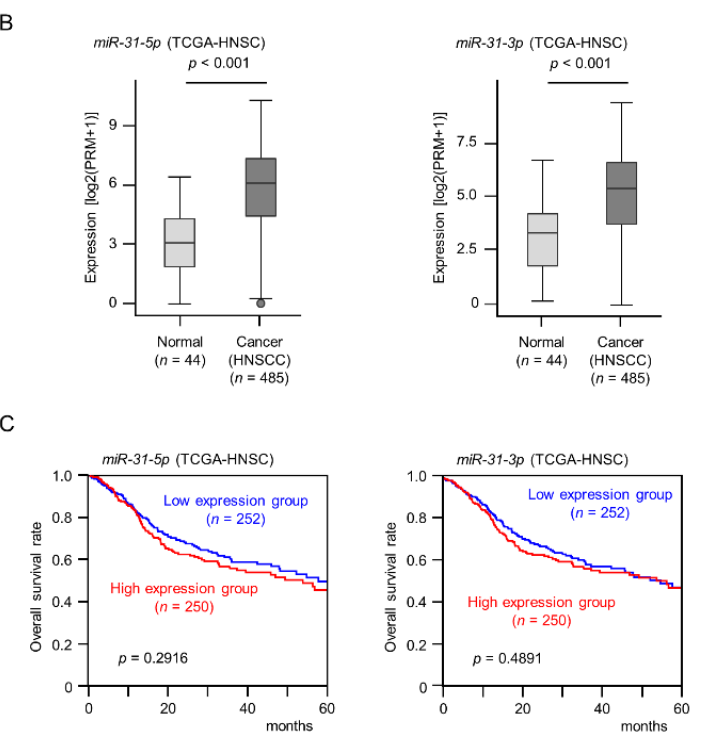
Figure 1. Clinical significance of miR-31-5p and miR-31-3p expression in HNSCC clinical specimens. ( A ) Heat maps of the 168 upregulated miRNAs in HNSCC clinical specimens. The color scale was based on Z-score of miRNA-seq expression data. ( B ) Expression levels of miR-31-5p and miR-31-3p were evaluated using TCGA-HNSC data. ( C ) Kaplan–Meier survival analyses of HNSCC patients using data from TCGA-HNSC. Patients were divided into two groups according to the median miRNA expression level: high and low expression groups. The red and blue lines represent the high and low expression groups, respectively.